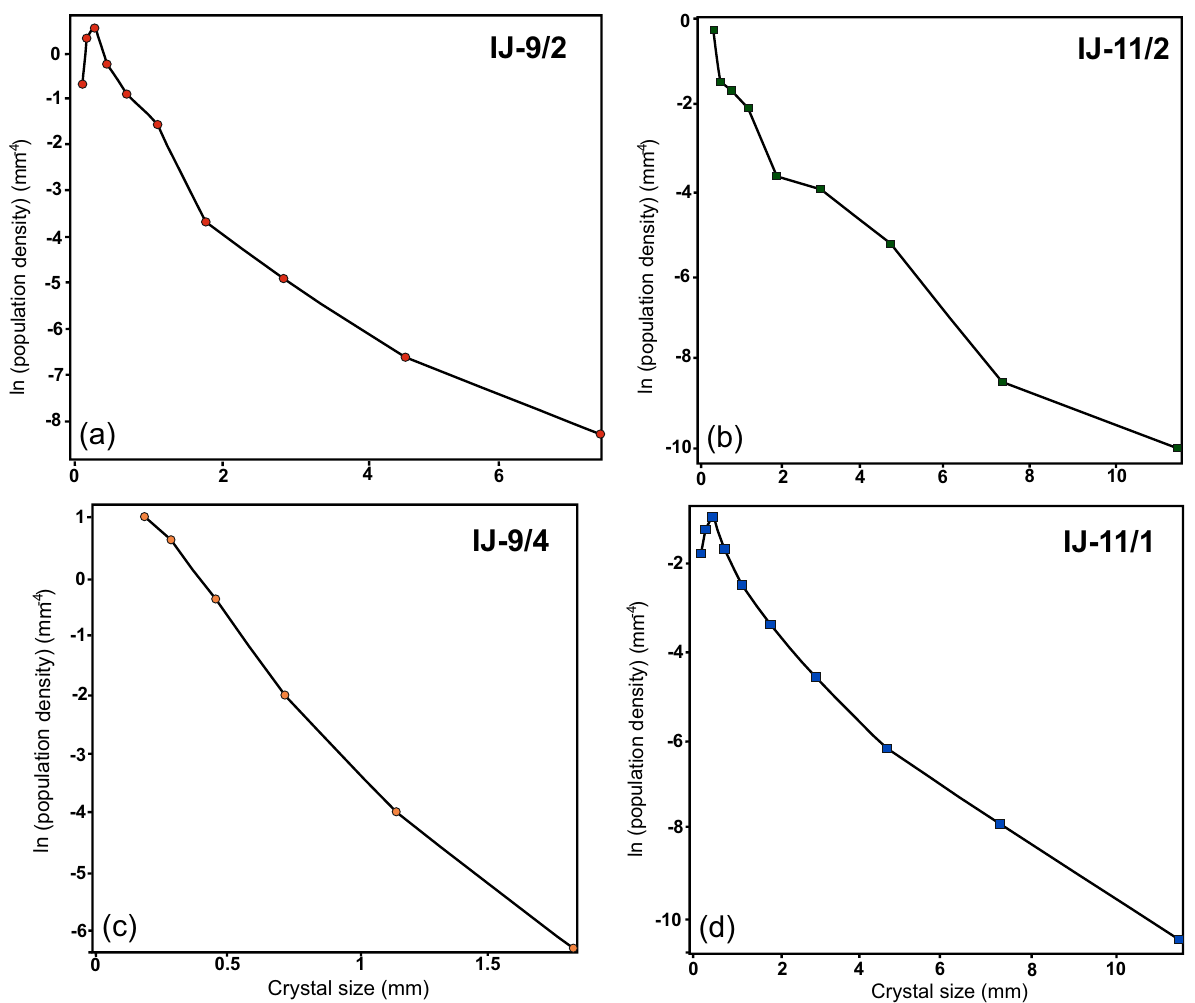
Fig. 4 Crystal size distribution plots. a , b and d CSD results of IJ-9/2, IJ-11/2, and IJ-11/1 showing concave upward patterns. c CSD results of IJ-9/4 with poikilitic texture showing almost straight